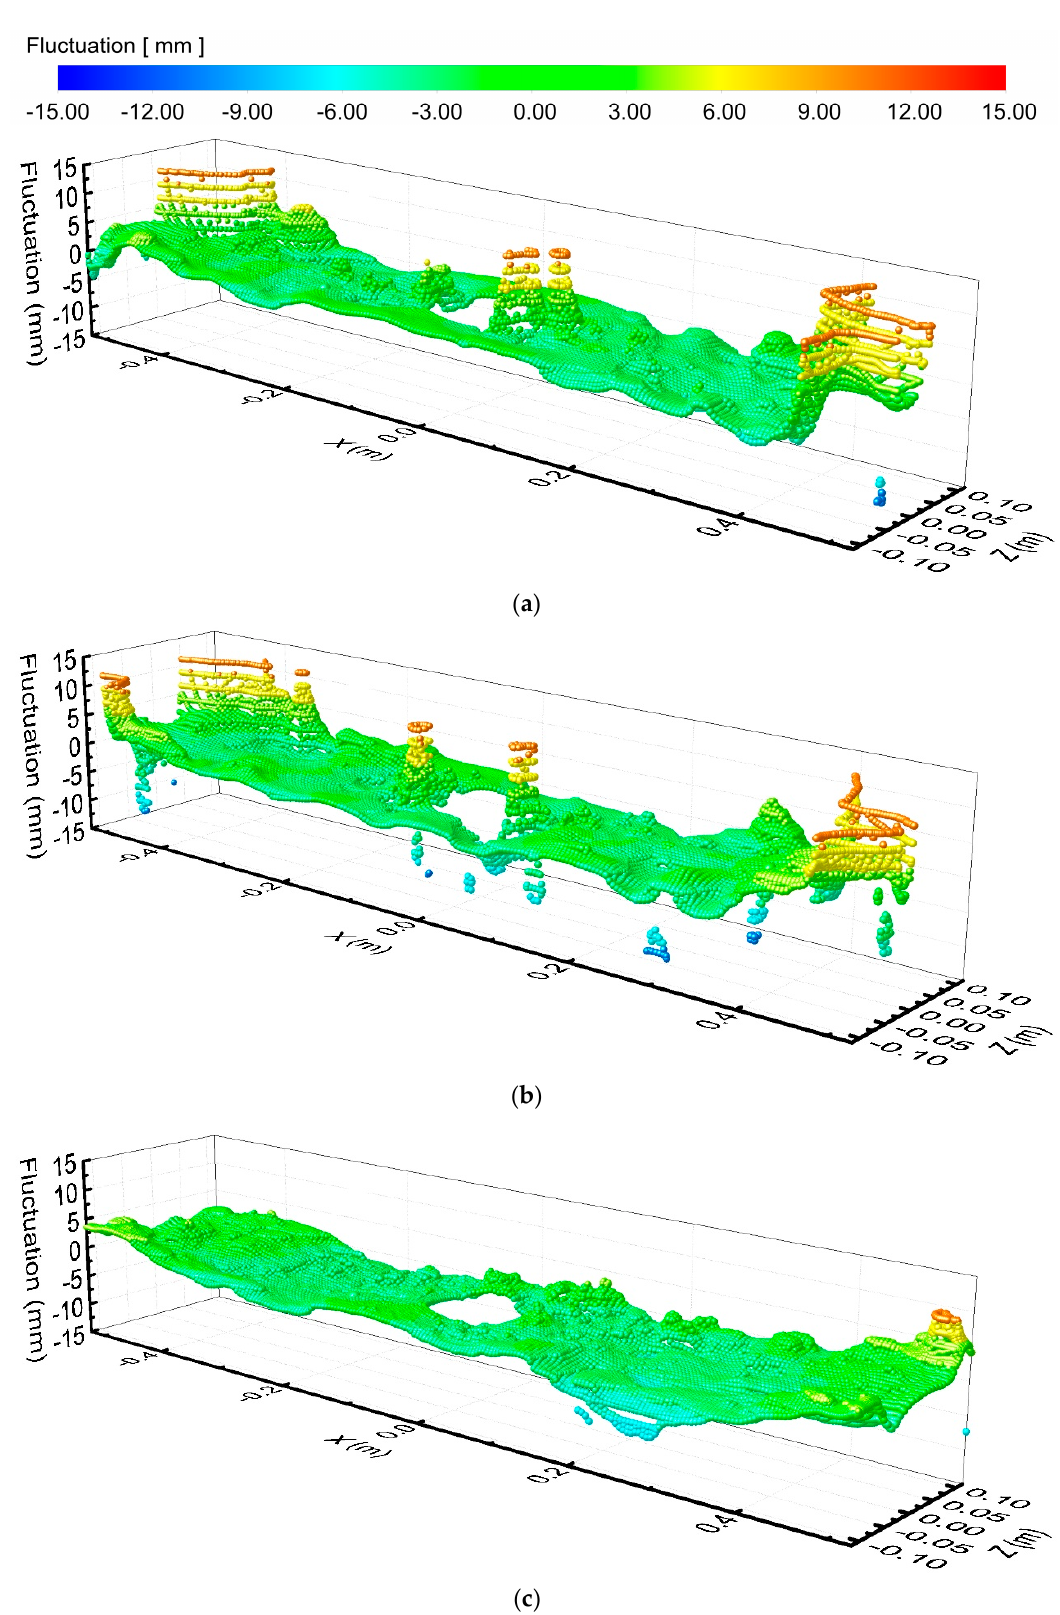
Figure 12. Fluctuation diagram of mold surface at argon flow rate of 6 L·min − 1 and under the differ- ent EMBr modes of: ( a ) Mode 1, ( b ) Mode 2, ( c ) Mode 3. different EMBr modes of: ( a ) Mode 1, ( b ) Mode 2, ( c ) Mode